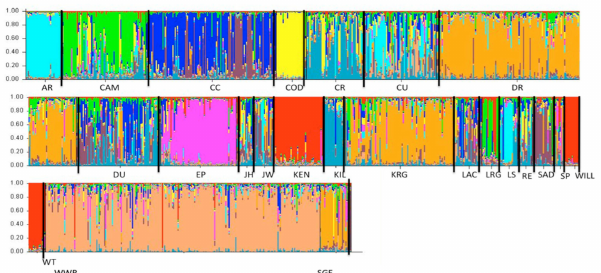
Figure 4. Wild pigs sampled at 24 sites during 2005–2009 in southern Texas, USA. Each individual is represented by a vertical line, which is partitioned into colored segments that represent the individual’s estimated membership fractions in the K = 10 genetic clusters derived from the Bayesian clustering algorithm Structure 2.2. Sampling sites are labeled below the figure. Aransas National Wildlife Refuge (AR), Cameron County (CAM), Choke Canyon State Park (CC), Kubala’s Ranch (COD), Comanche Ranch (CR), Cuero County (CU), Don Ricardo pasture, Laureles Division of King Ranch (DR), Duval County (DU), El Pintor Ranch (EP), Jim Hogg County (JH), Jim Wells County (JW), Kenedy Ranch (KEN), Killam Ranch (KIL), Gallito pature, Laureles Division of King Ranch (KRG), the Texas A&M Extension Service La Copita Research Area (LAC), Lower Rio Grande Valley National Wildlife Refuge (LRG), La Salle County (LS), Rancho Escondido (RE), Santa Gertrudis division of King Ranch (SGE), San Diego County (SAD), South Pasture-Texas A&M-Kingsville (SP), Willacy County (WILL), Wilbarger Tract, Lower Rio Grande Valley National Wildlife Refuge (WT), and Rob and Bessie Welder Wildlife Refuge